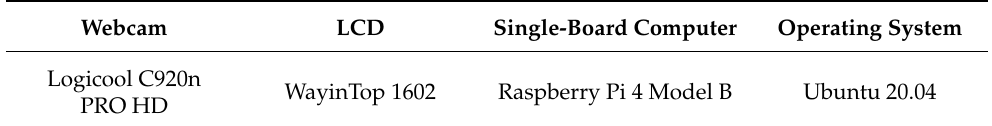
Table 9. The handheld device